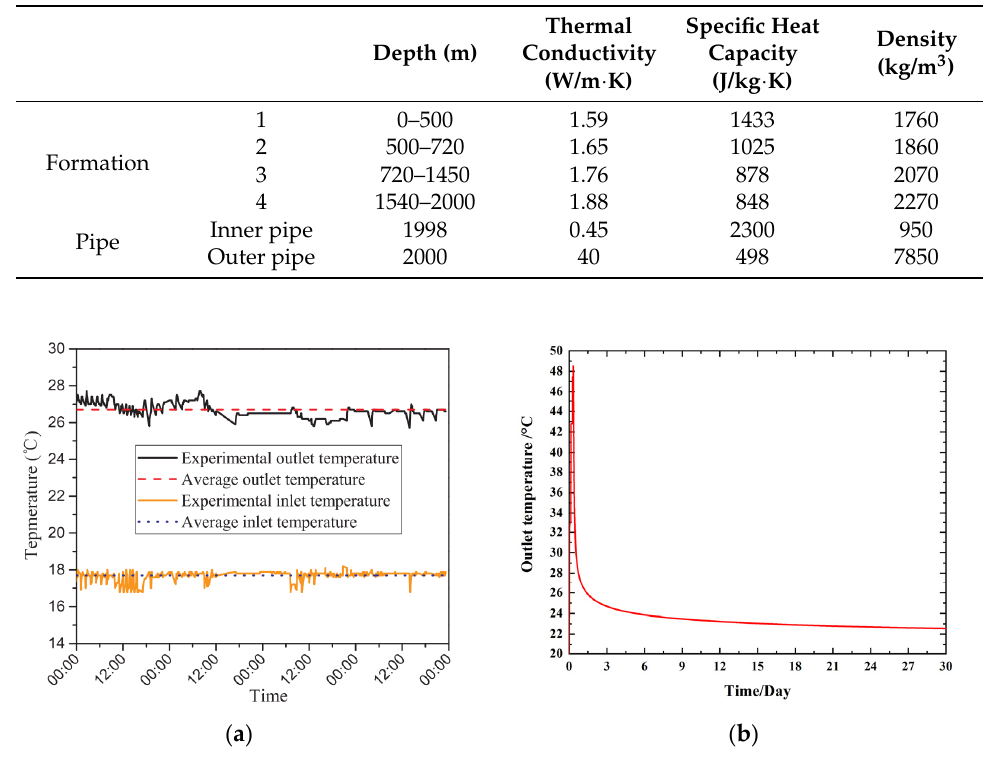
Figure 4. ( a ) Outlet temperature of demonstration project [14], ( b ) outlet temperature of simula-